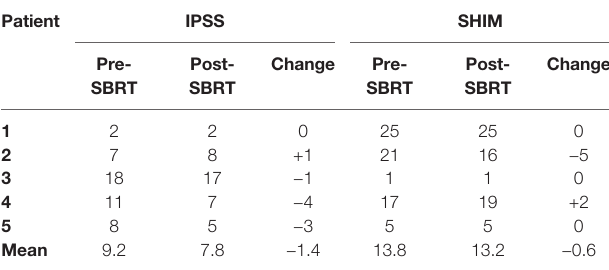
SHIM, sexual health inventory for men; IPSS, International Prostate Symptom Score.